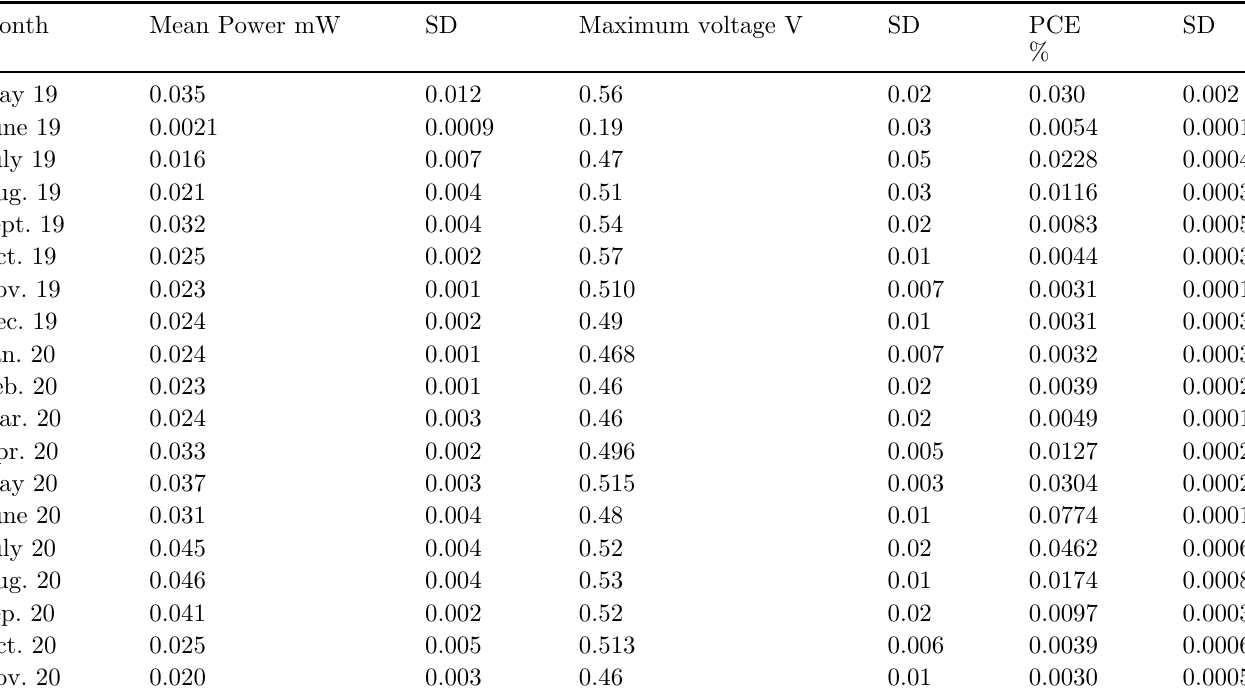
Table 2. Mean power, mean maximum voltage and mean power conversion ef fi ciency generated by KD12 along the evaluated period. Mean and SD values were calculated from the six highest values of each